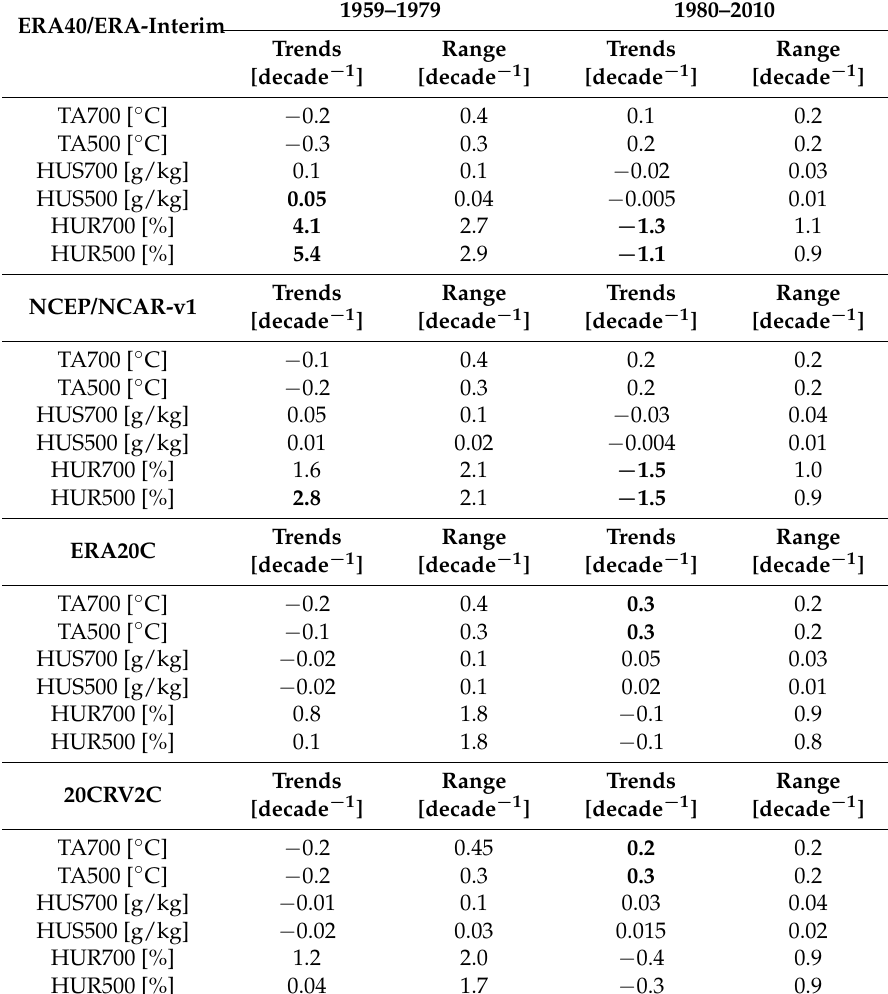
Table 3. Annual trends and their Snedecor uncertainty range for the 95% confidence interval computed for 1959–1979 and 1980–2010. The values in bold indicate that the trends are statistically significant at the 95% confidence level, namely that they are larger than the associated uncertainty